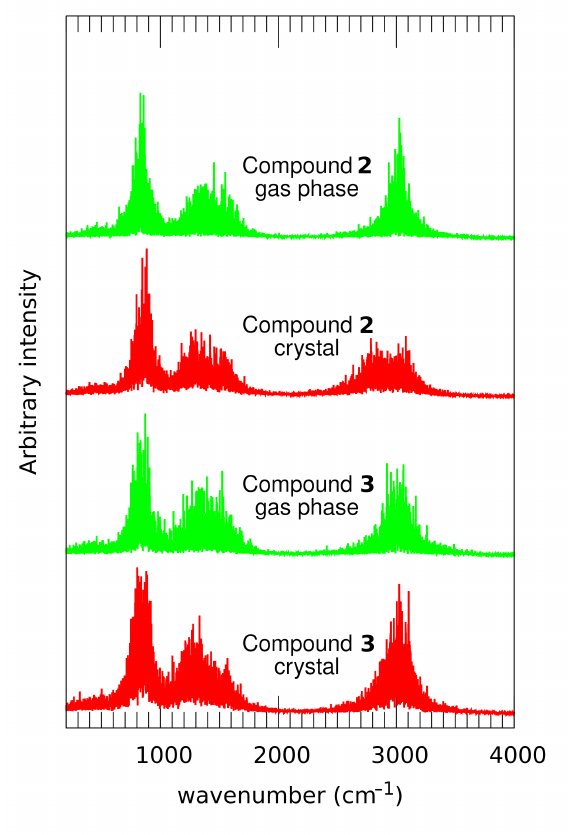
Figure 10. Vibrational features of the bridge protons in the studied compounds. Results of the gas phase and solid state CPMD simulations for compound 2 , 1,8-dihydroxy-9,10-anthraquinone, and compound 3 ,